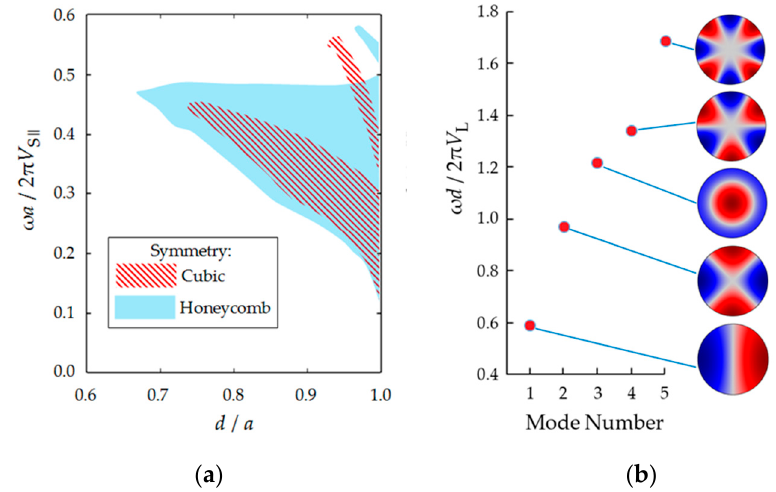
Figure 2. ( a ) Dependence of position and width of the full bandgap on the diameter of the scatters d and the lattice constant a in stainless steel matrix with cubic and honeycomb symmetries; ( b ) eigenmodes of liquid-filled cylinders.